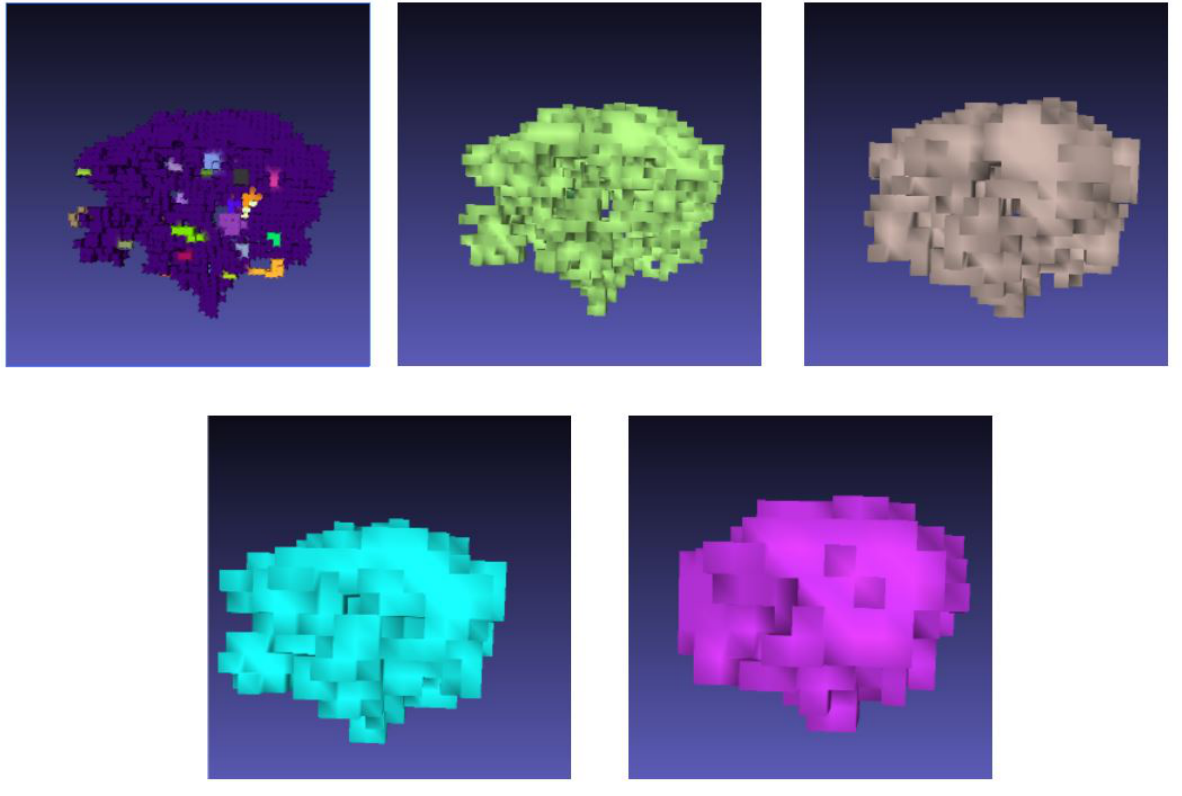
Figure 5. Voxel connectivity of 6 connected